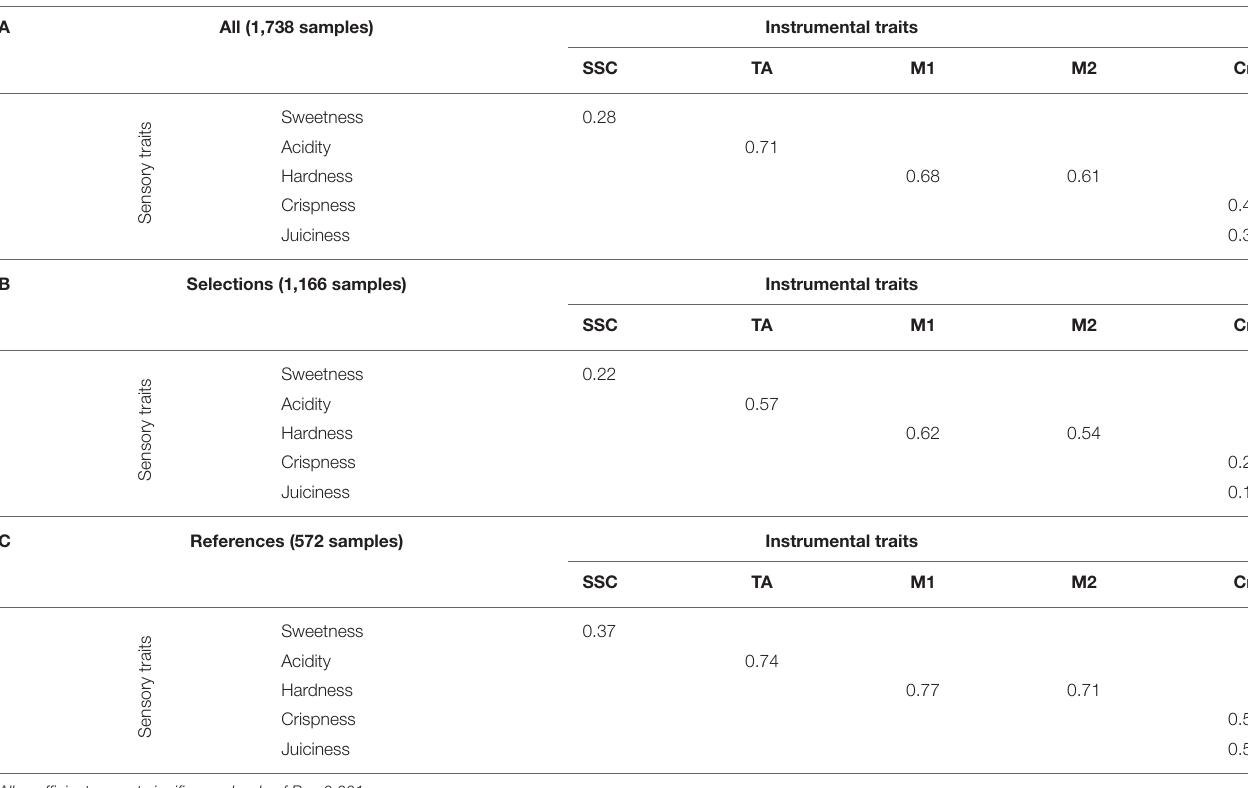
TABLE 2 | Spearman’s rank correlation of instrumental traits and corresponding sensory traits for (A) all samples, (B) phase two selections only, and (C) reference cultivars only from Washington State University apple breeding program.